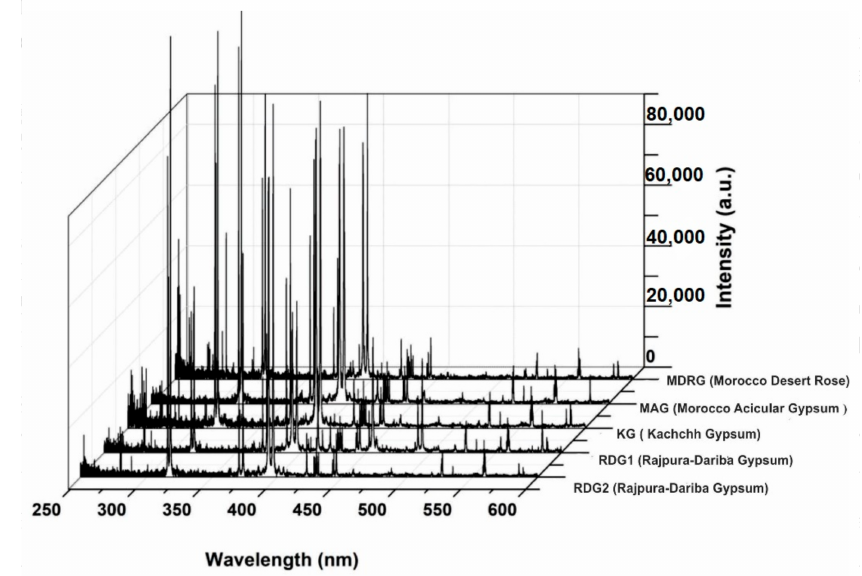
Figure 4. Typical laser-induced breakdown spectroscopy (LIBS) spectra (250–600 nm) of di ff erent gypsum samples analyzed during the present study stacked to show the relative intensity variations amongst the